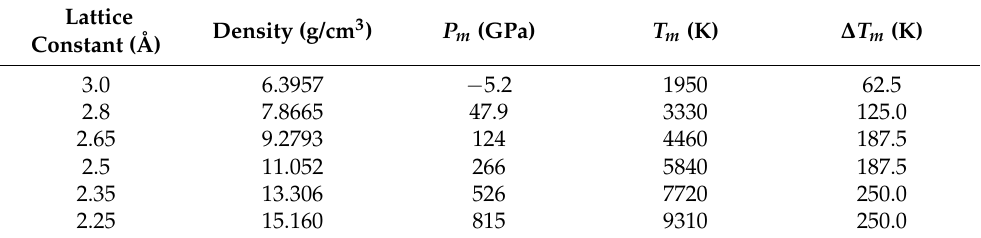
Table 1. The six ab initio melting points of bcc-Cr, ( P m , T m ± ∆ T m ) , obtained from the Z method implemented with